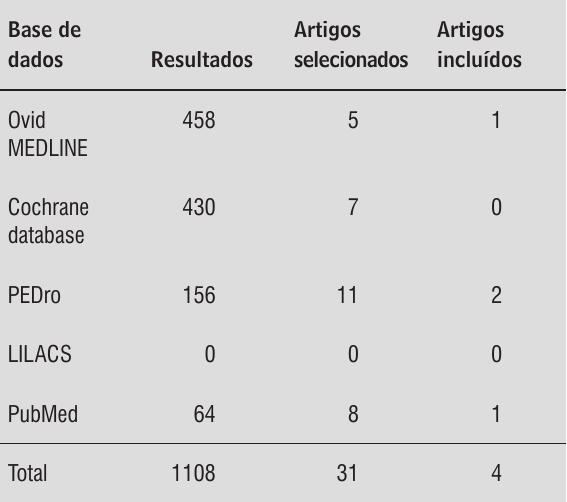
Tabela 2 - Resultado da busca literária nas